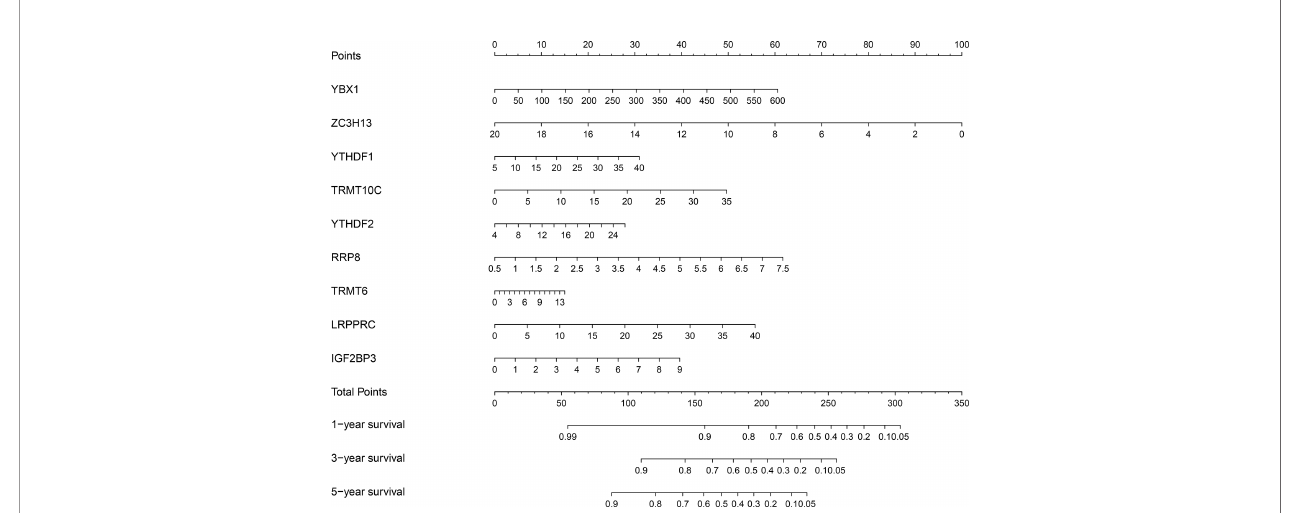
FIGURE 7 | Prognostic nomogram based on the 9 m6A/m5C/m1A-regulated genes in HCC patients. HCC, hepatocellular